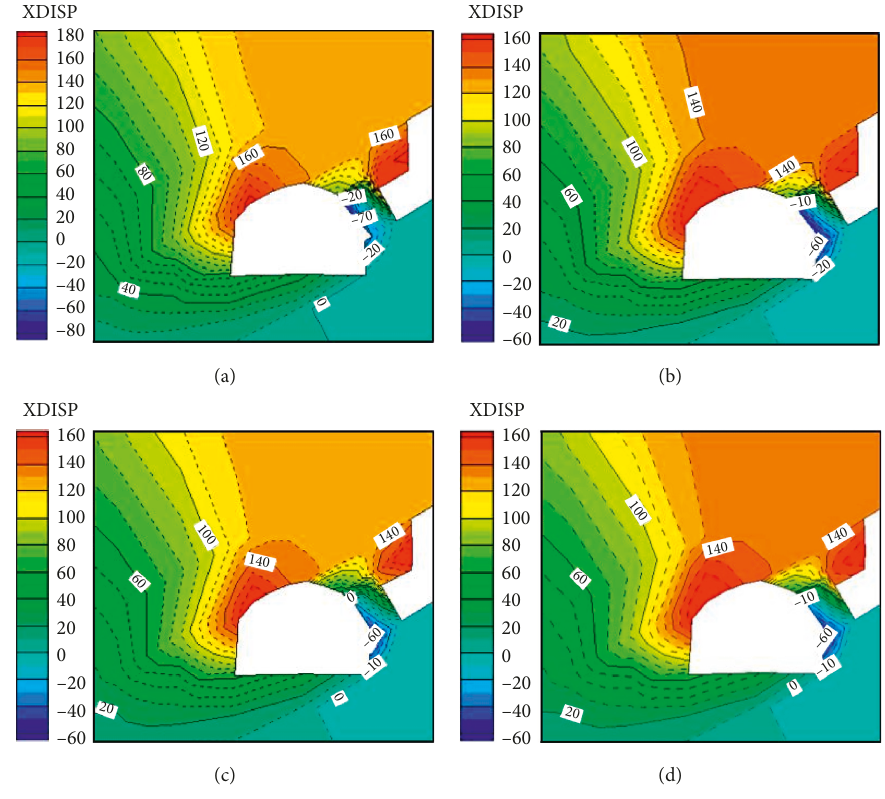
Figure 25: Horizontal displacements of different concrete materials: (a) C40, (b) C50, (c) C60, and (d) LC50.